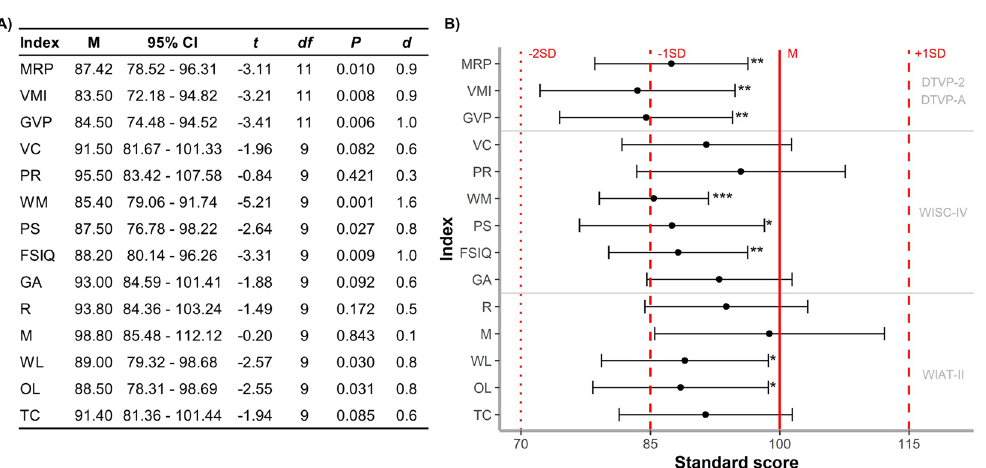
Figure 2. (A) Descriptive statistics ( M and 95% CI ) and results of the one-sample t-tests ( t statistic, P values and Cohen’s d ). (B) Mean (dot) and 95% confidence interval (error bar) of each test (individual and composite indices). Vertical red lines represent test norms: mean (solid), 1 standard deviation (dashed) and 2 standard deviation (dotted). * P ≤ 0.05, ** P ≤ 0.01, *** P ≤